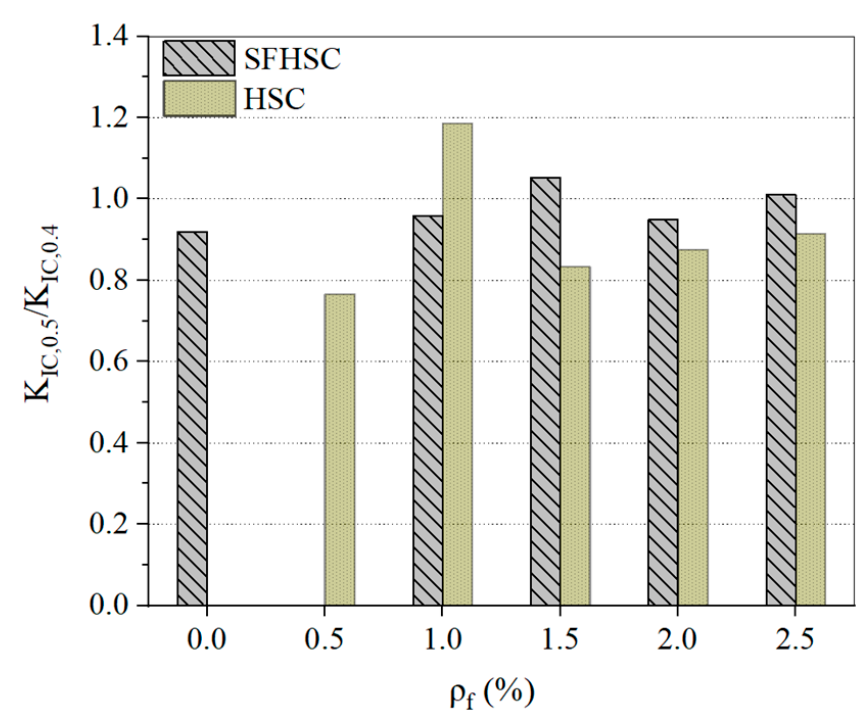
Figure 11. Influence of notch depth on the K IC of SFHSC and